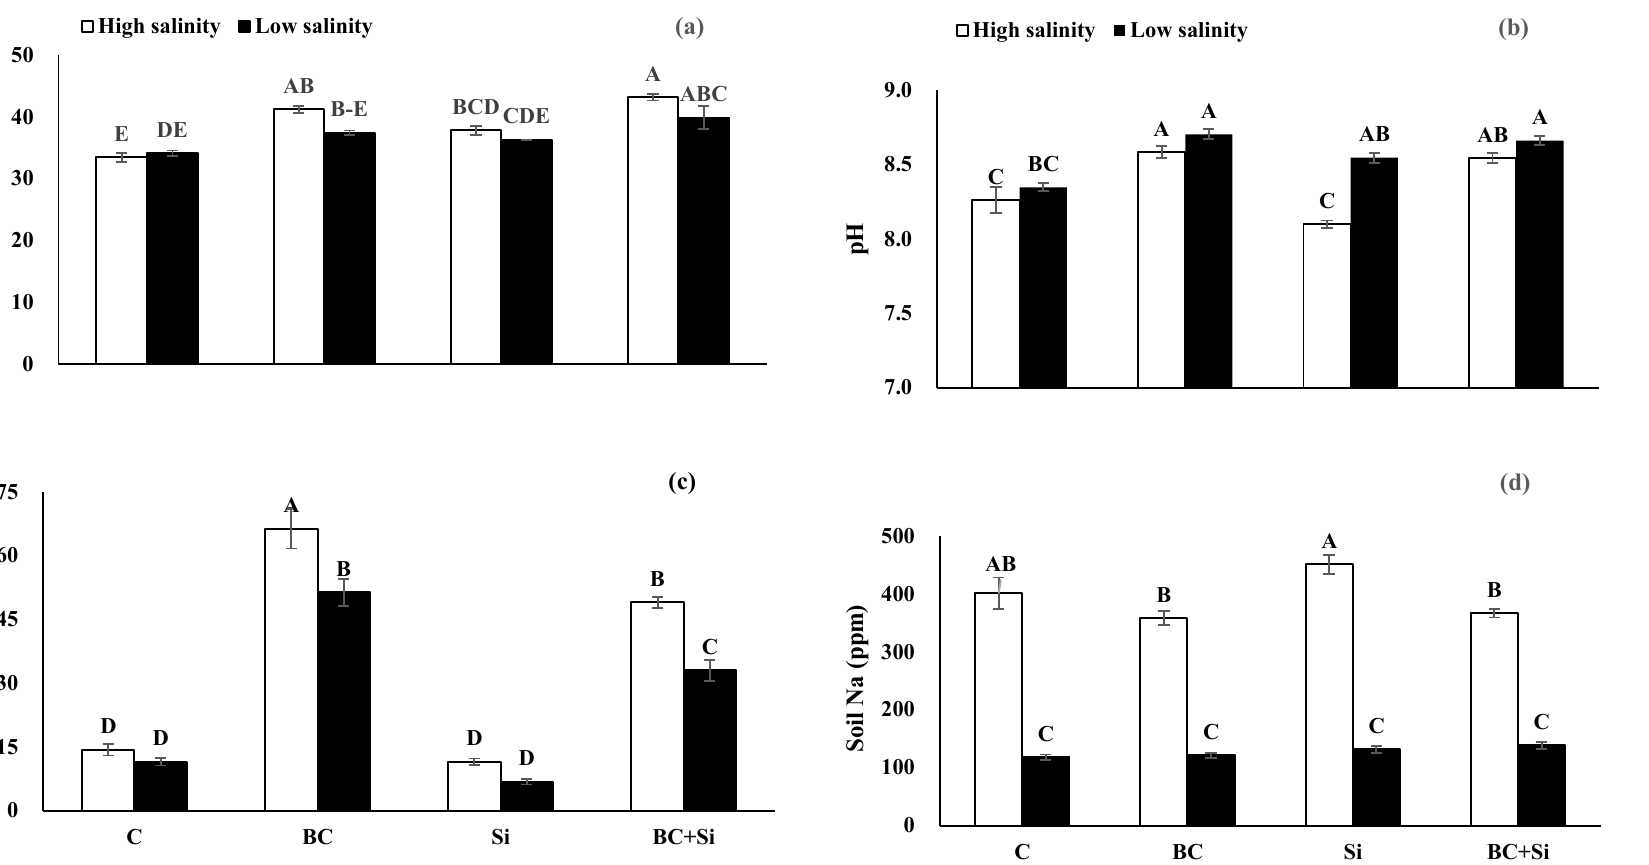
Figure 2. Effect of salt level and soil amendments on soil ( a ) water-holding capacity (WHC), ( b ) pH, and ( c ) K and ( d ) Na concentrations ± S.E. C = control; BC = biochar; Si = silica; BC + Si = biochar + silica. Means sharing the same letters do not differ significantly at p < 0.05.